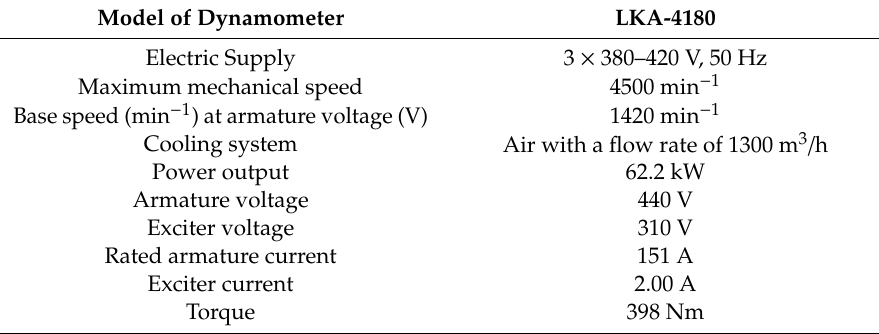
Table 3. Specifications of the 40-kW direct current